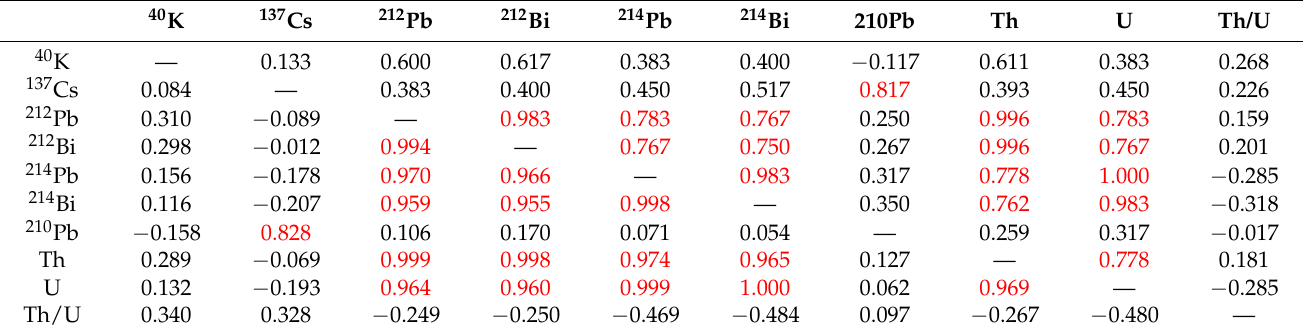
Table 1. The matrix of Pearson’s (lower diagonal) and Spearman’s (upper diagonal) correlation coefficients of activity concentration distribution of investigated radionuclides. The correlations valid at p < 0.05 are represented in